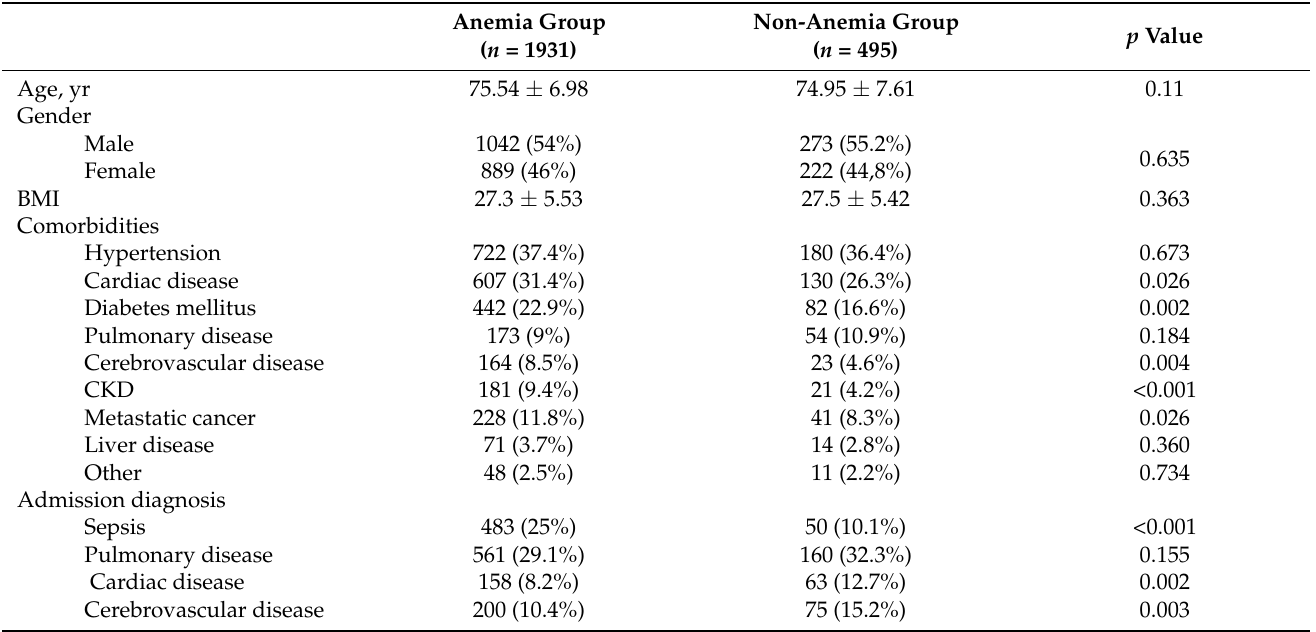
Figure 1. Flow chart of the study. ICU, intensive care unit; AF, atrial fibrillation. Table 1. Patient demographic and medical characteristics during the ICU stay.